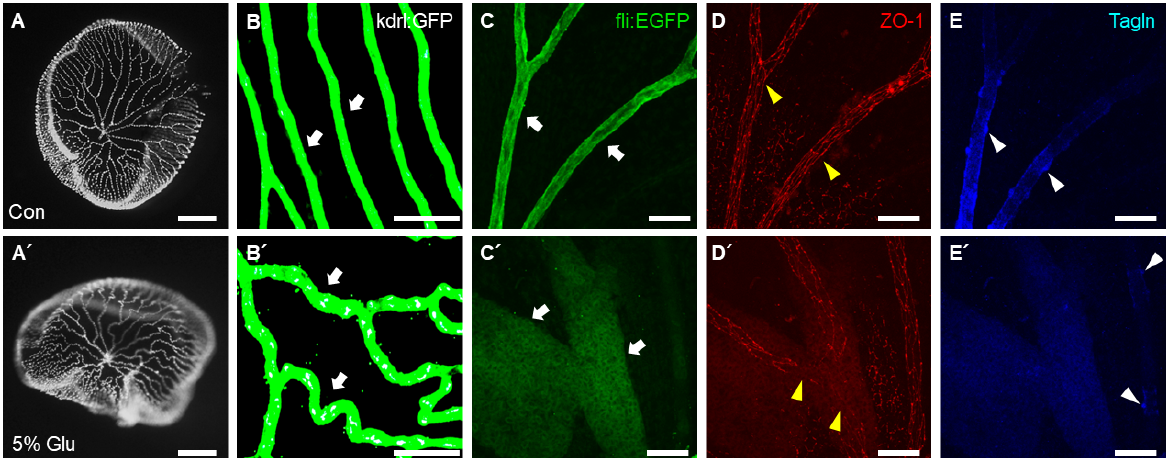
Figure 5. Changes in the retinal vasculature in high glucose-treated adult zebrafish. Vessel diameter was increased in high glucose-treated zebrafish ( A’ – E’ ) compared to the control ( A – E ). Confocal fluorescent image of vascular GFP expression ( B , B’ , C , C’ ), anti-ZO-1 ( D , D’ ), or anti-Transgelin ( E , E’ ) antibody staining. Arrows indicate retinal vessels. Arrowheads indicate representative cells stained with the specific antibody. Scale bars, 200 μ m for ( A , A’ ), 100 μ m for ( B , B’ ), and 50 μ m for ( C – E ) and ( C’ – E’ ).